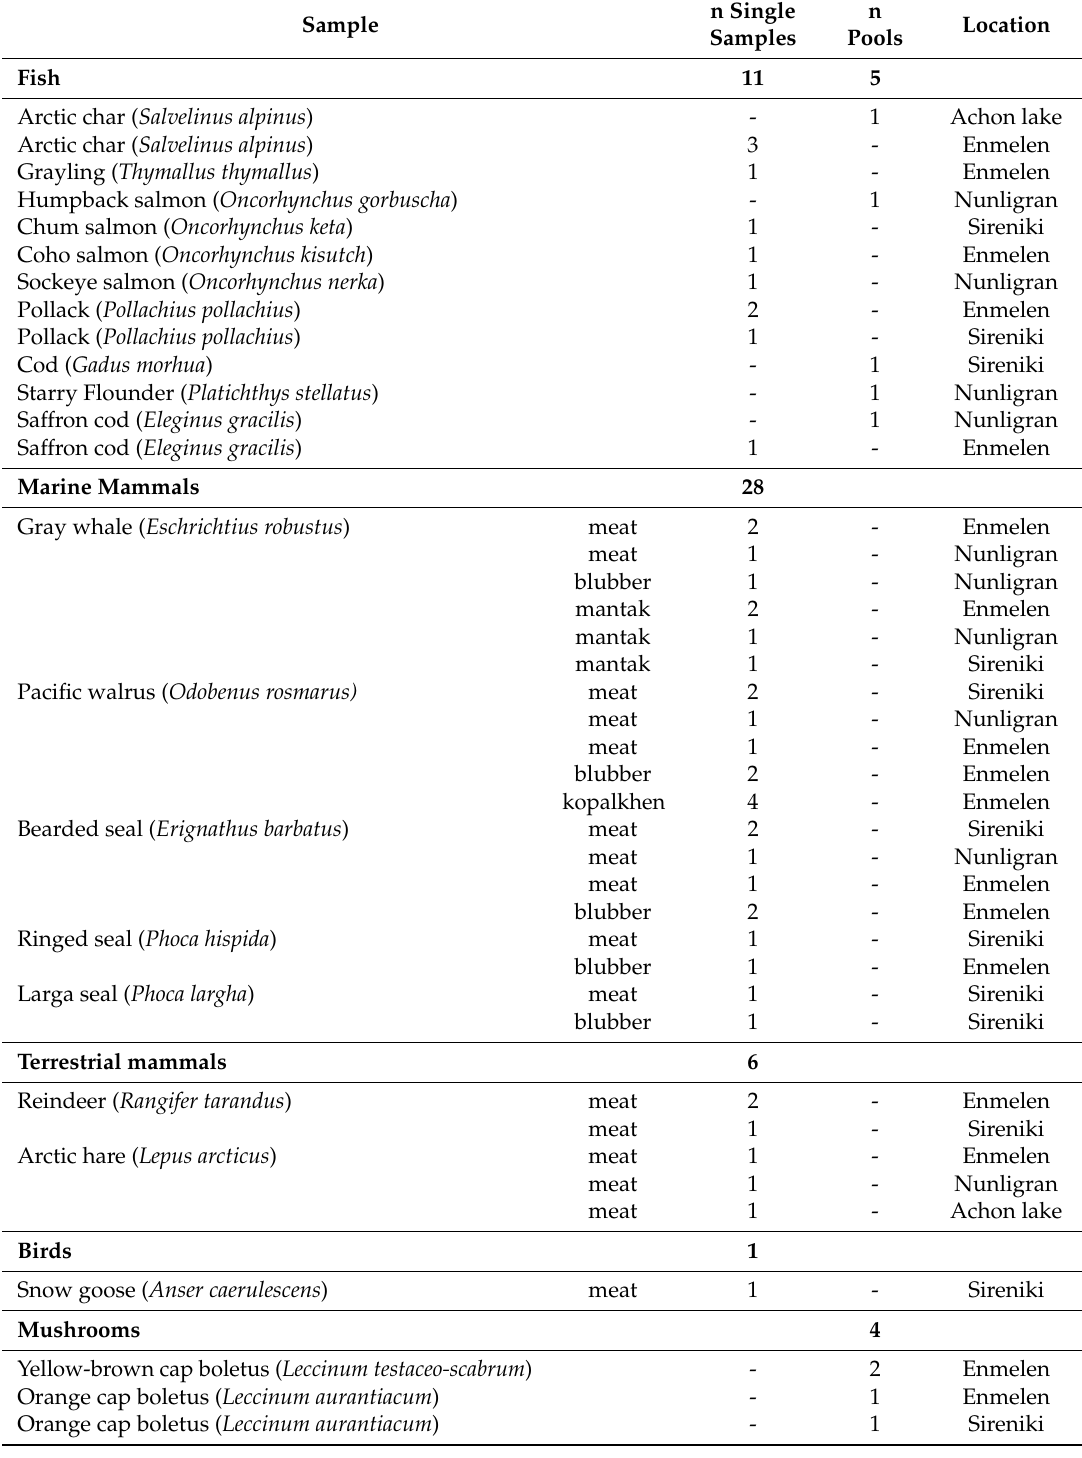
Table 1. Collected and analyzed samples of local foods, drinking water, and indoor matters: numbers and locations.